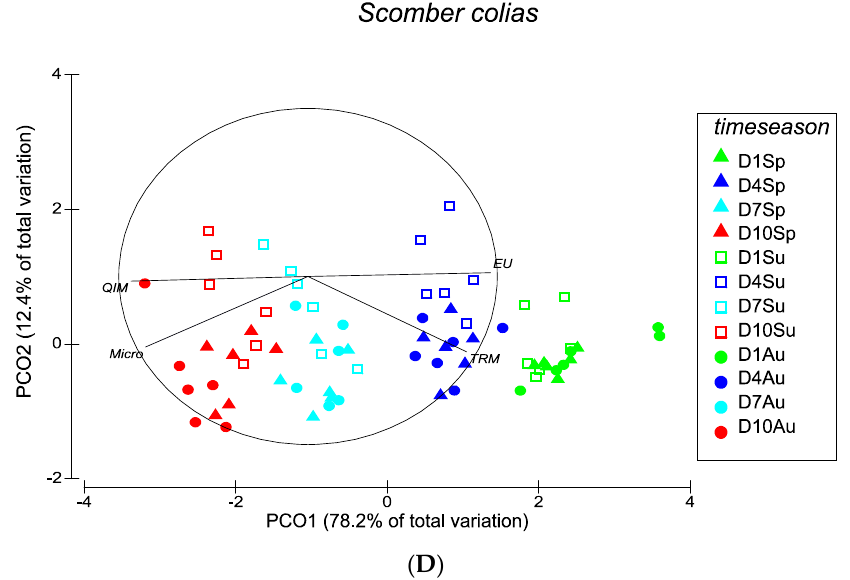
Figure 5. PCO ordinations for ( A ) Sparus aurata , ( B ) Dicentrarchus labrax , ( C ) Trachurus trachurus , and ( D ) Scomber colias assessed through four methods (QIM, EC scheme, TRM, and microbiology) for the different seasons over the 10 days of ice storage based on Spearman correlations. The length and direction of each vector indicate the strength and sign, respectively, of the relationship between the used methods and PCO axes. Sp—spring; Su—summer; Au—autumn; Wi—winter.